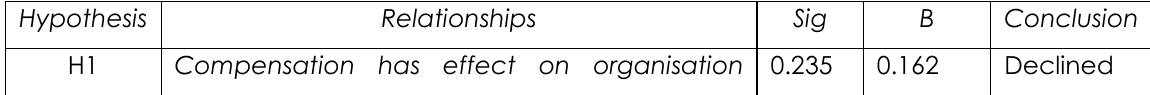
Table 5. Hypotheses